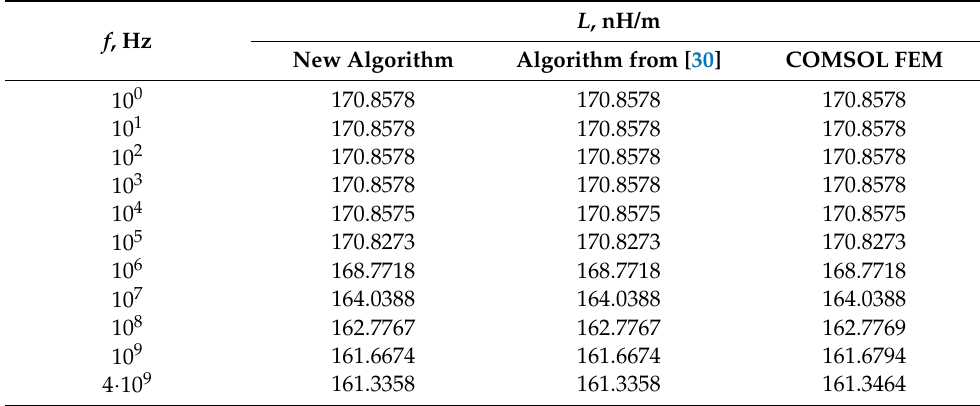
Table 3. Comparison of the inductance p.u.l. for the first validation example.